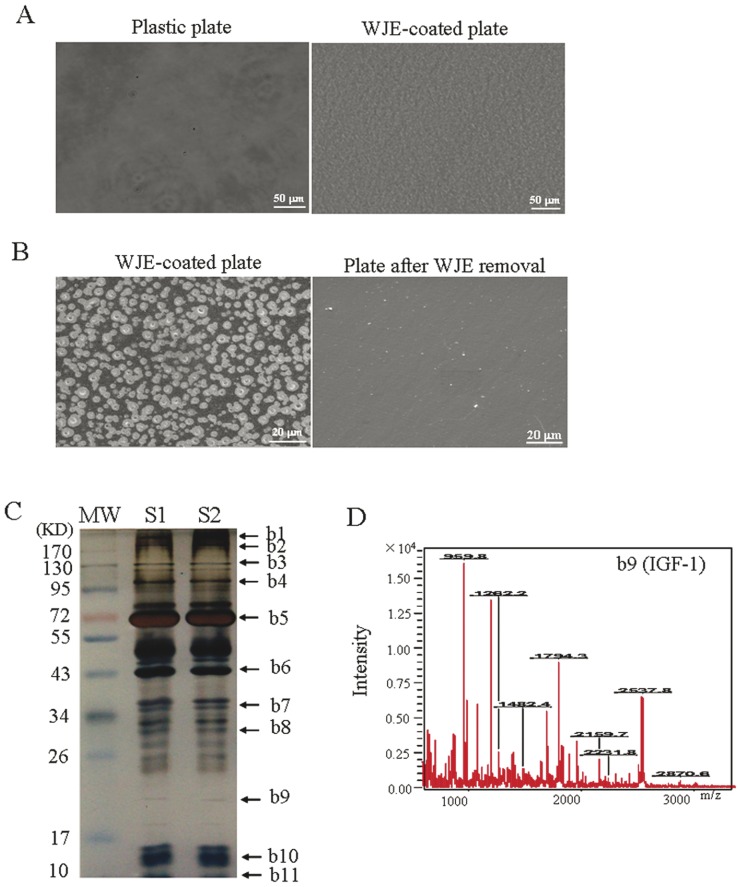
Characteristics of Wharton's Jelly extracts (WJE).(A) Micrographs from phase contrast microscopy of WJE-coated plates. Scale bars, 50 µm. (B) Scanning electron microscope images of WJE-coated plates. Scale bars, 20 µm. (C) Protein removed from WJE-coated plates analyzed by electrophoresis. (D) Mass spectra of a 21 kDa protein band by in-gel digestion with porcine trypsin (representative image). MW, molecular weight. S, sample. b, band.